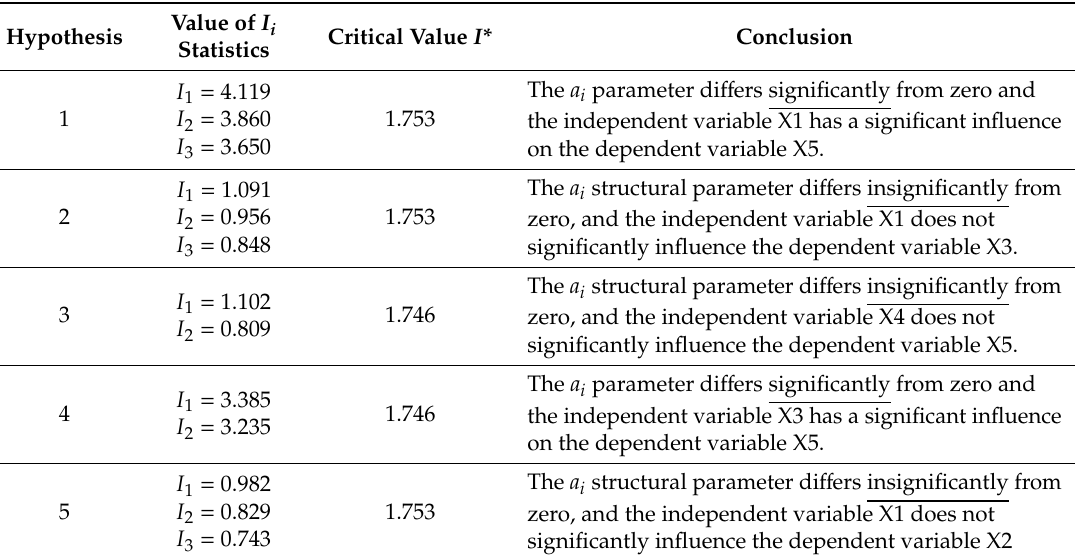
Table 4. Values of t -Student’s statistics for the